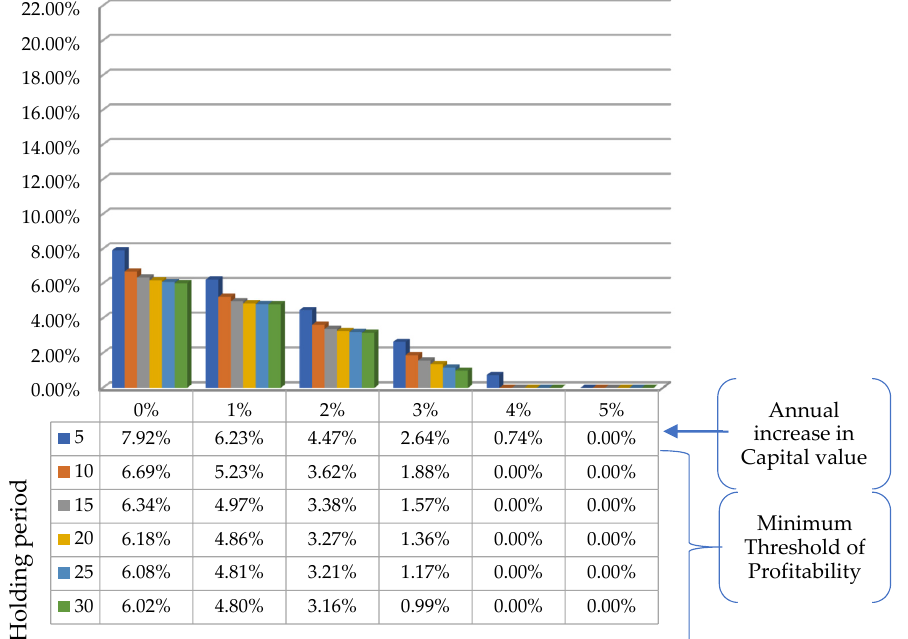
Figure 5. Distribution of the Pmt depending on the annual increase in capital value and the holding period.